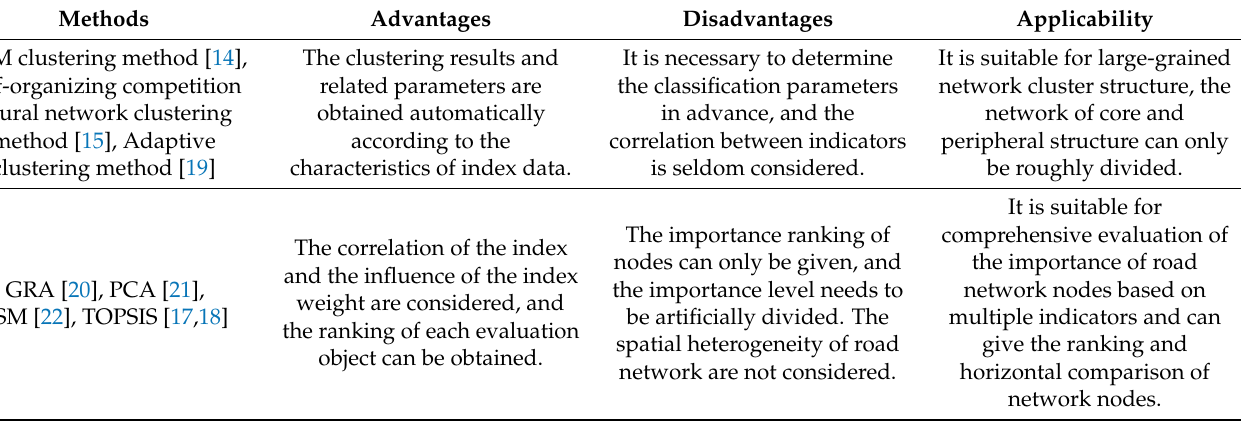
Table 1. Description of some comprehensive evaluation